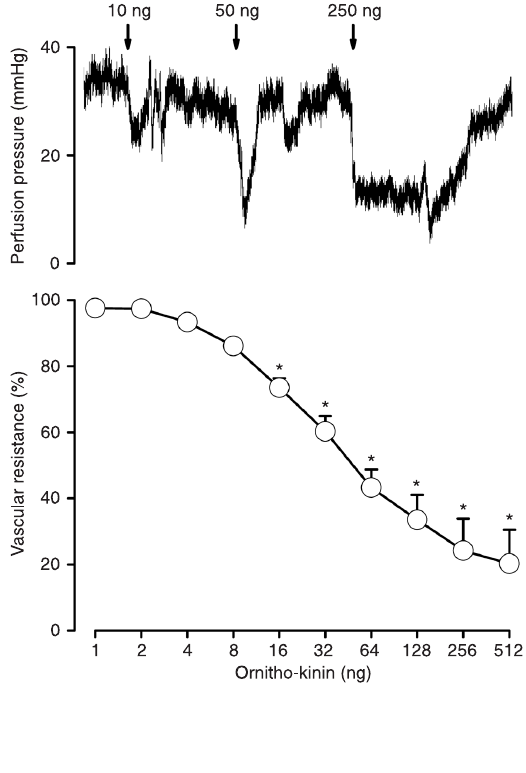
Figure 3. Effect of pretreatment with ornitho-kinin on changes in arterial pressure and heart rate induced by coronary artery occlu- sion (CAO) and reperfusion in anesthetized chickens. The long arrow indicates pretreatment (saline or ornitho-kinin, 500 µg/kg infused into the right ventricle for 5 min). Data are 1-min aver- ages. Numbers on the X-axis indicate the following periods: 1 = just before the start of the experiment; 2 = in the middle of the period of infusion; 3 = just before CAO; 4 = at the end of 1 h of CAO; 5 = after 1 min of reperfusion, and 6-8 = after 1, 2, and 3 h of reperfusion, respectively. Data are reported as means ± SEM for 8 animals each dose. * P < 0.05 vs baseline (ANOVA followed by the paired t